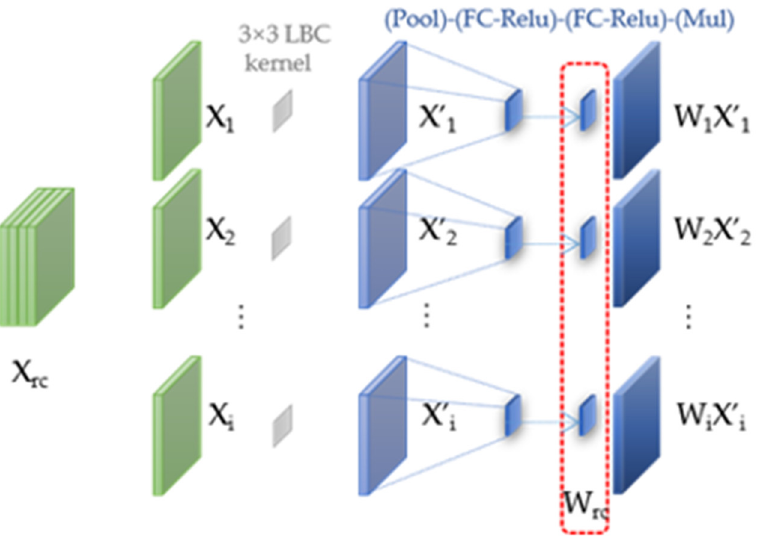
Figure 4. Relationship between LBC kernel and SE weight; each weight corresponds to a 3 × 3 LBC kernel.